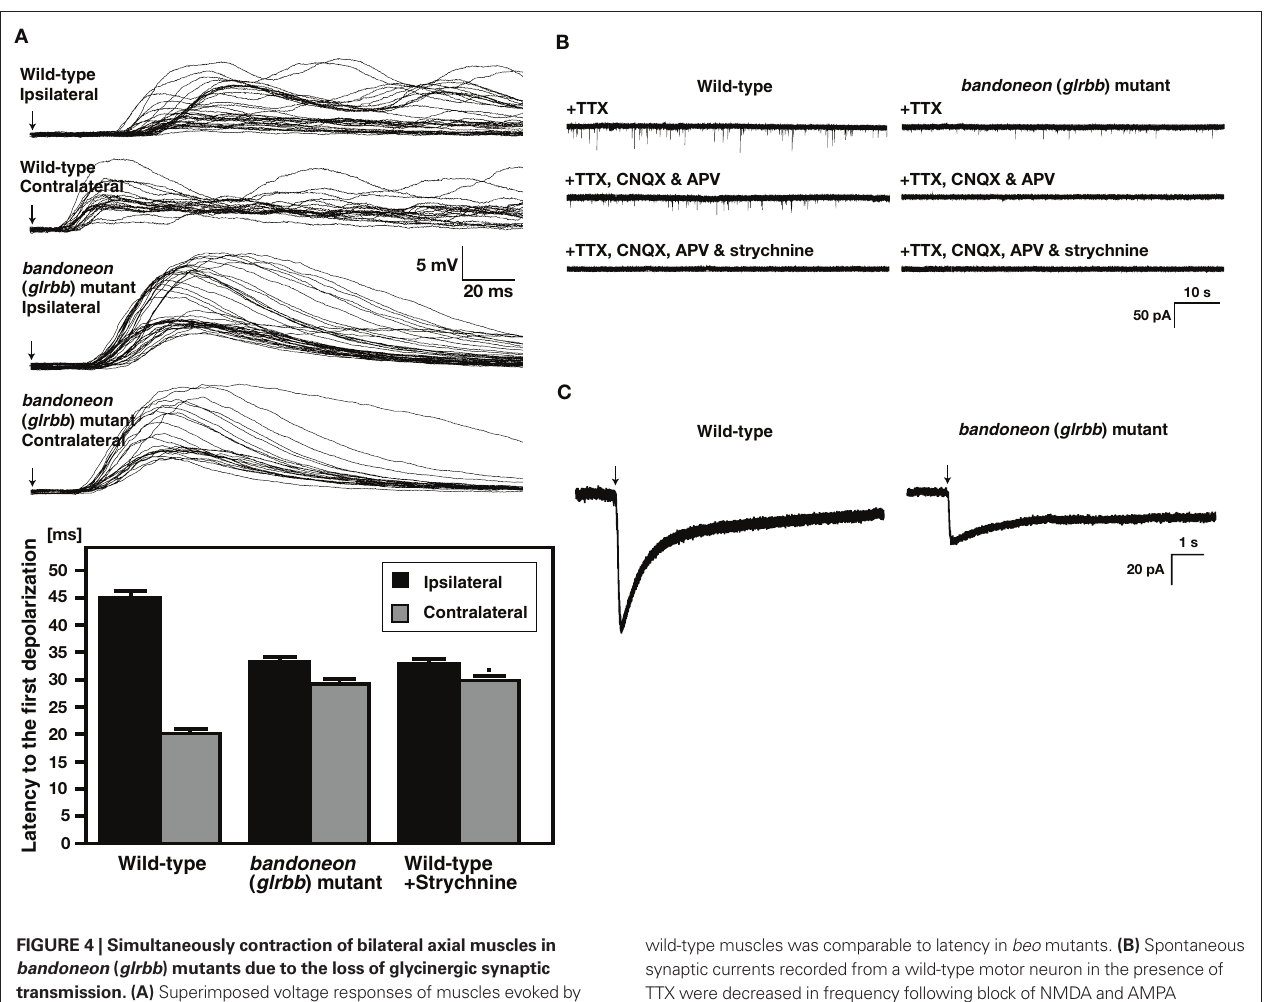
wild-type muscles was comparable to latency in beo mutants. (B) Spontaneous synaptic currents recorded from a wild-type motor neuron in the presence of TTX were decreased in frequency following block of NMDA and AMPA receptors by application of CNQX and APV, respectively. The non-glutamatergic currents in wild-type are eliminated by further application of strychnine, showing that they are glycinergic currents. In beo , non-glutamatergic currents in the presence of CNQX and APV are missing, indicating that glycinergic synaptic currents are absent. (C) A puff of exogenous glycine induced a current in a wile-type motor neuron and a smaller current in a beo mutant motor